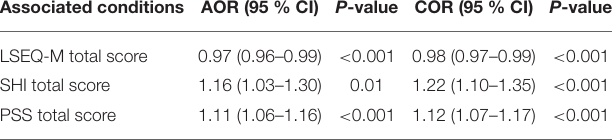
TABLE 2 | Binary logistic regression: association of anxiety with psychological stress, poor sleep, and inadequate sleep hygiene in Ethiopian collegiate young